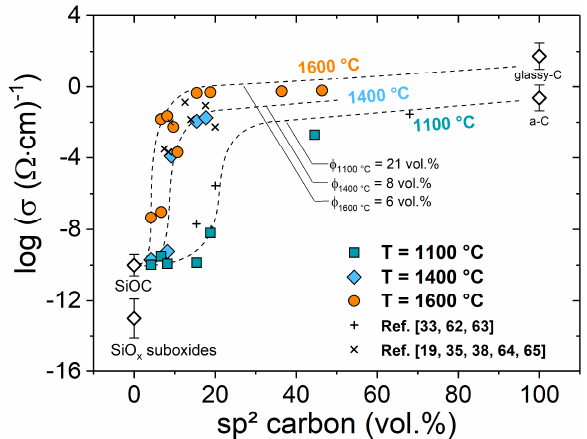
Figure 5. The electrical conductivity of SiOC/C as a function of the sp² carbon for three different